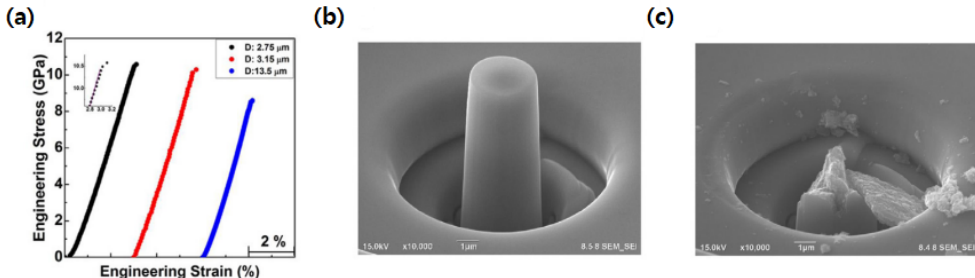
Figure 7. ( a ) Engineering stress–strain curve of n ‐ SiC micropillars obtained by compression test. ( b ) ( b ) Scanning electron micrograph showing fabricated n-SiC micropillar with a diameter of 1.6 µ m. Scanning electron micrograph showing fabricated n ‐ SiC micropillar with a diameter of 1.6 μ m. ( c ) Scanning electron micrograph showing fractured n ‐ SiC micropillar by intergranular mode. Repro ‐ ( c ) Scanning electron micrograph showing fractured n-SiC micropillar by intergranular mode. Repro- duced with permission from [69]. Copyright 2022 Elsevier. duced with permission from [69]. Copyright 2022